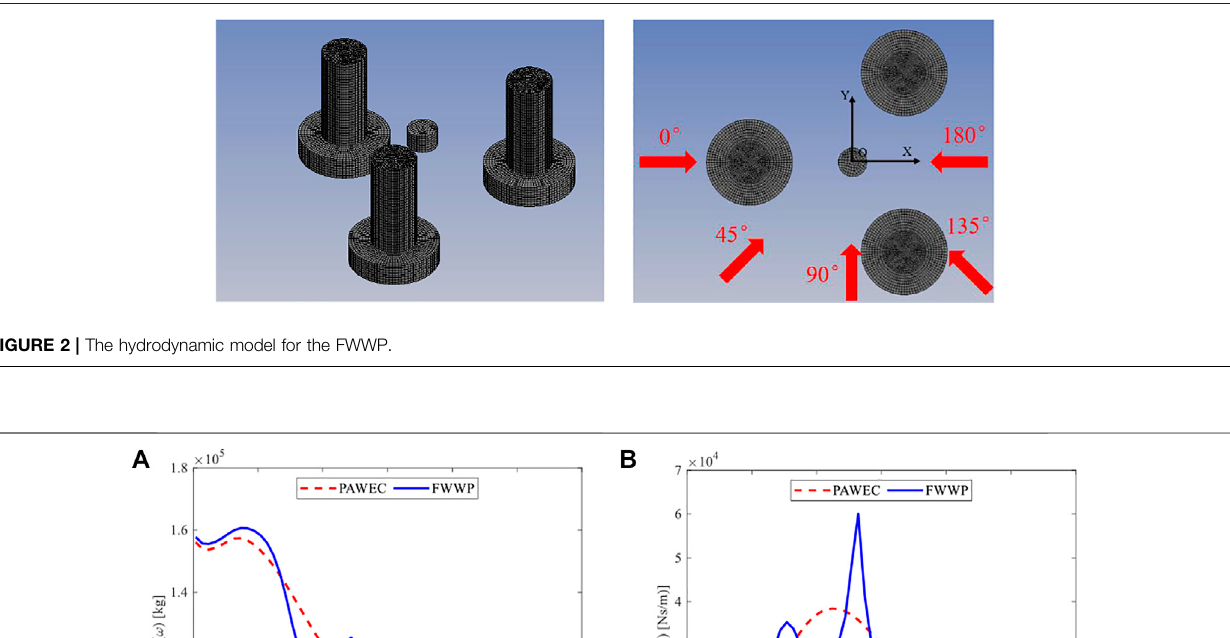
Frontiers in Energy Research |